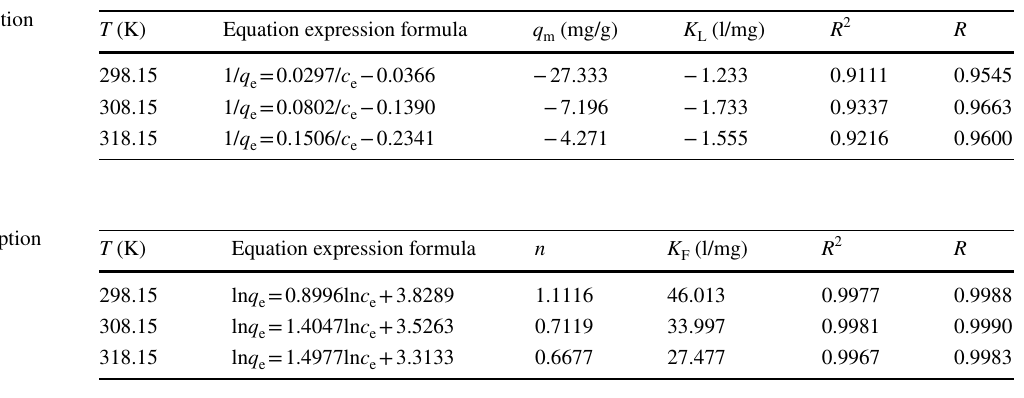
Fig. 5 Van’t Hoff curve; m (MCM-41) = 0.3 g, t = 40 min, pH = 4.5, C Pb2+ = 1 mg/ml